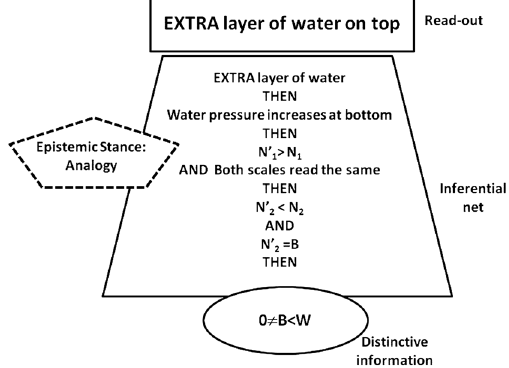
FIG. 6. Schematic diagram of the projection described in S 3 . a perspective that avoids the problematic contact surface at stance simply as analogy . Figure 6 gathers the pieces coordinated in this projection in a schematic way.